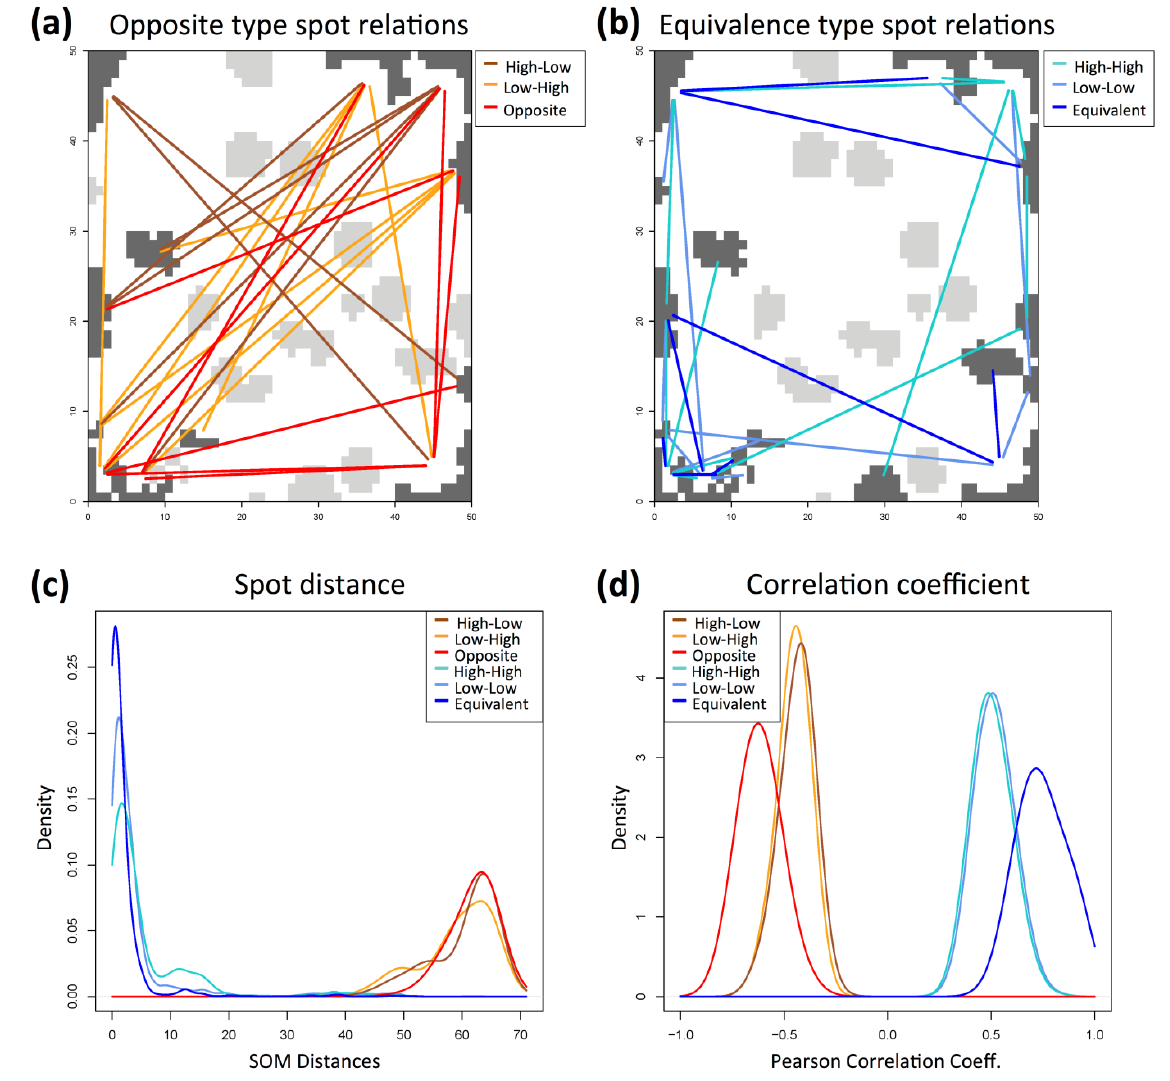
Figure 7: Spot module relations derived from single gene implications. Mapping of the opposite and equivalence type relations of the spot modules into the SOM space (panels a and b, respectively). Distribution plots of the distances bridged by the six implication types and of the according Pearson correlation coefficients of the spot module profiles (panels c and d, respectively). Note the greater spot distances and lower correlation coefficients of LH, HL, HL and HH implications relative to OPP and EQV